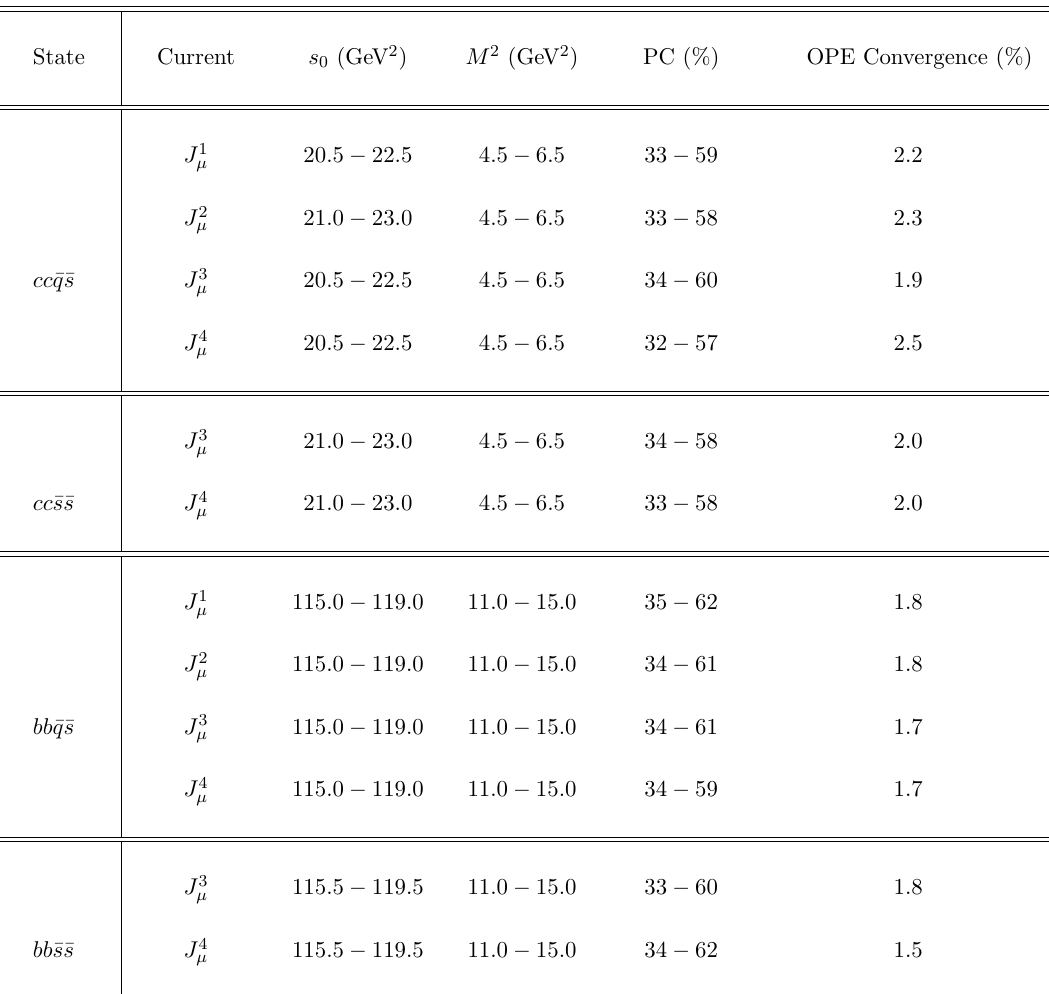
Table 1 . Working intervals of s 0 and M 2 as well as the PC and OPE convergence for the MDMs of T QQ ¯ q ¯ s and T QQ ¯ s ¯ s